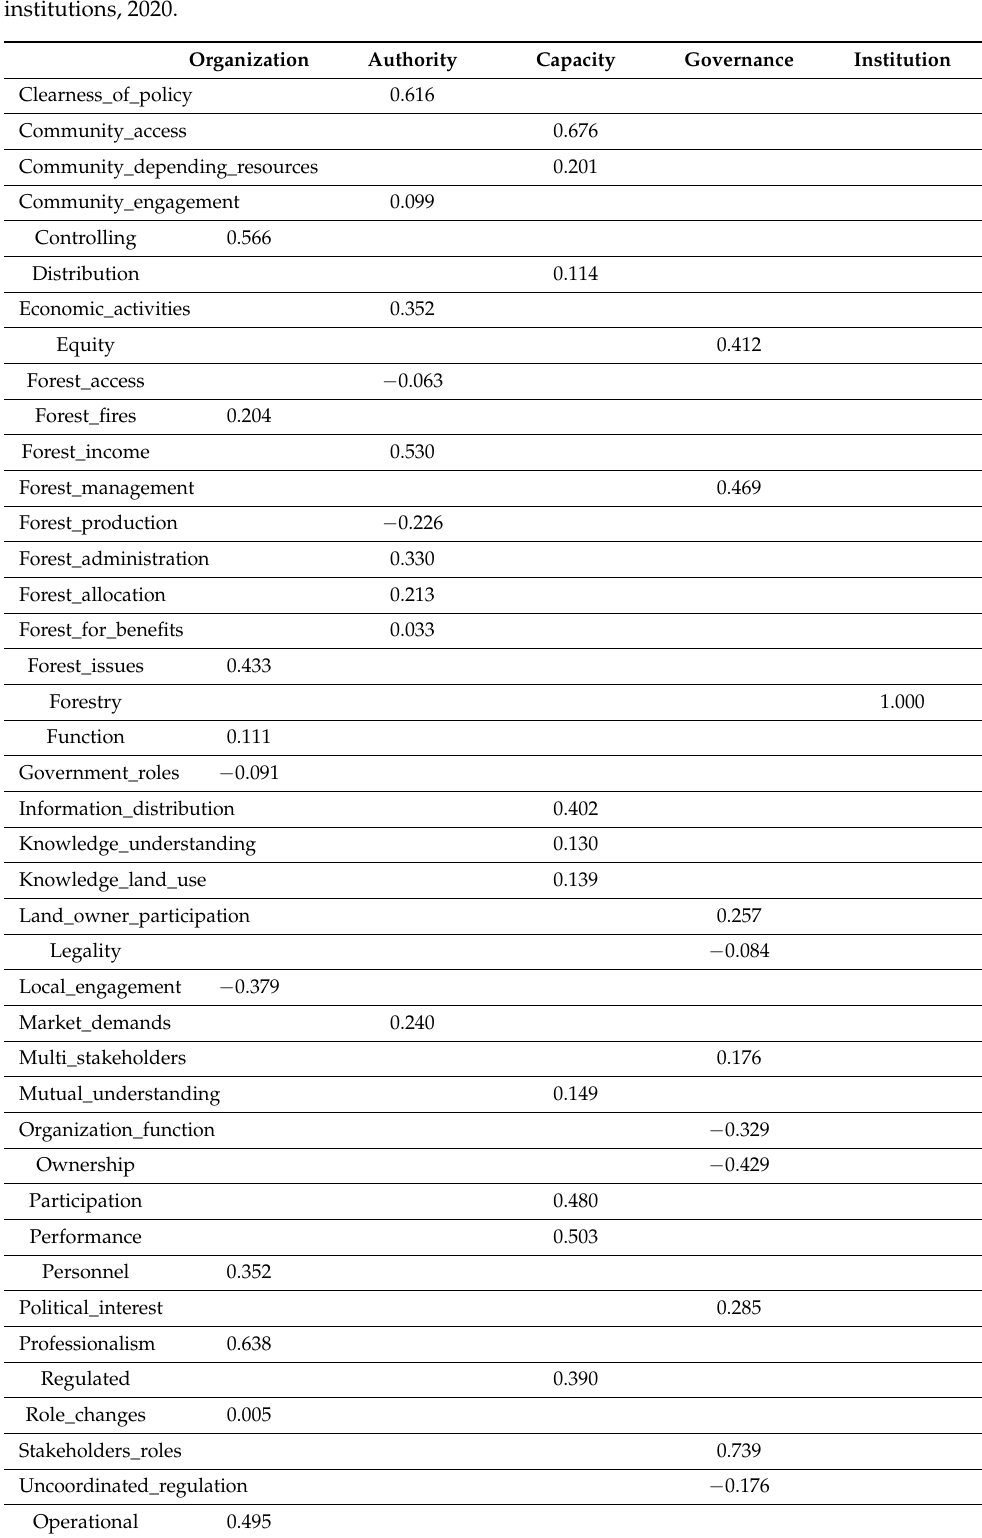
Table 2. Correlation results for significant variables (dimensions) related to strengthening local institutions,